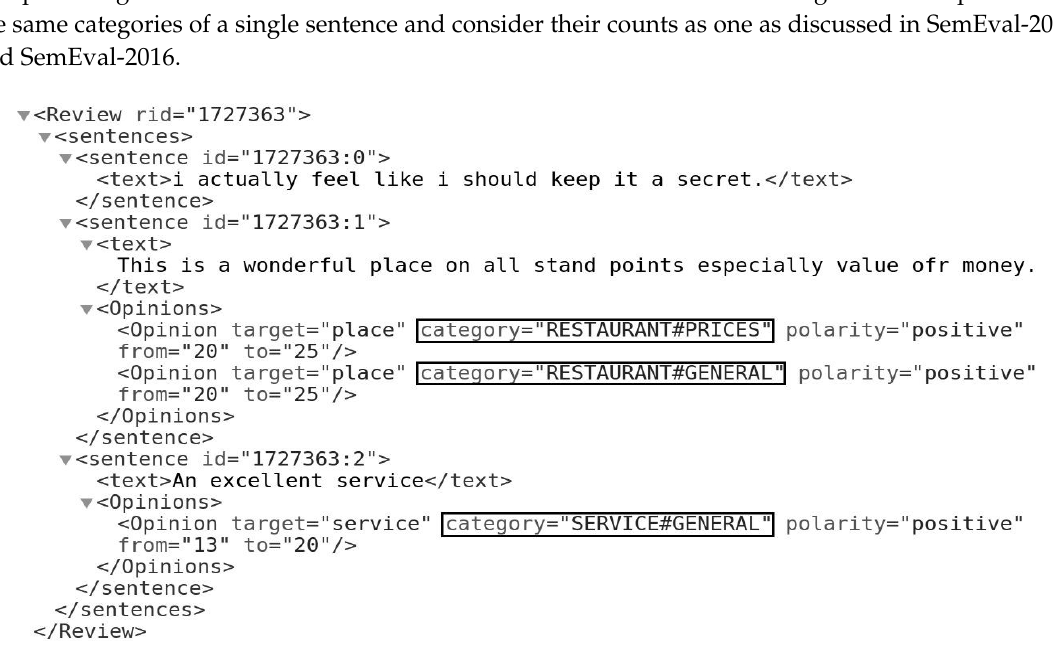
Figure 3. Annotation of sentences in a single training review instance in English restaurant reviews dataset. Table 2. Aspect categories distribution across training and test sentences.